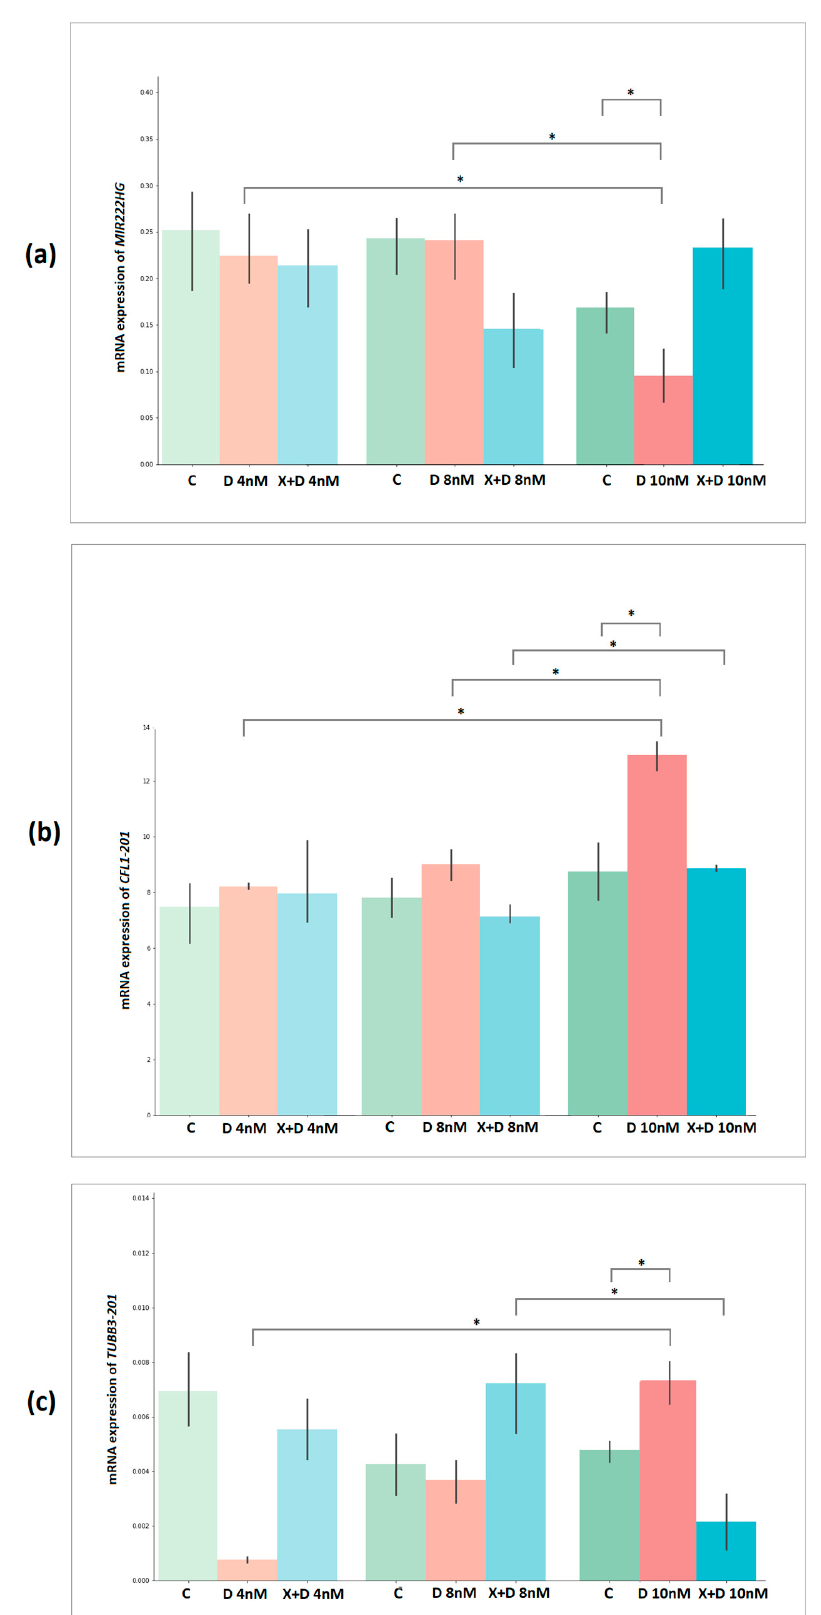
Figure 5. Bar plots showing relative expression results for ( a ) MIR222HG, ( b ) CFL1-201 and ( c ) TUBB3-201 transcripts between experimental groups of PC3 cells. The y -axis represents the 2 − ∆ CT values. C—control, D—docetaxel, X+D—XAV939+Docetaxel. *—significant